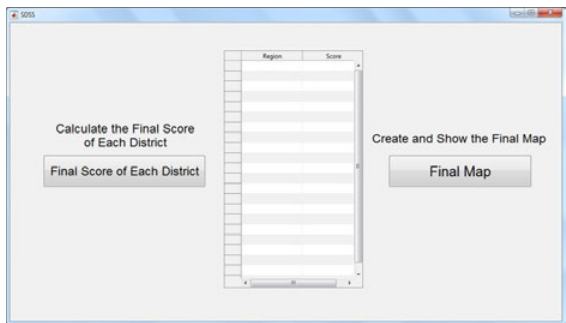
Fig. 6: The user interface of the SDSS; Third step: Preparing the final map of prioritizing the districts Table 3: Districts with the highest and lowest priority for the construction of multiplex buildings based on each index Districts with the highest priority Districts with the lowest priority